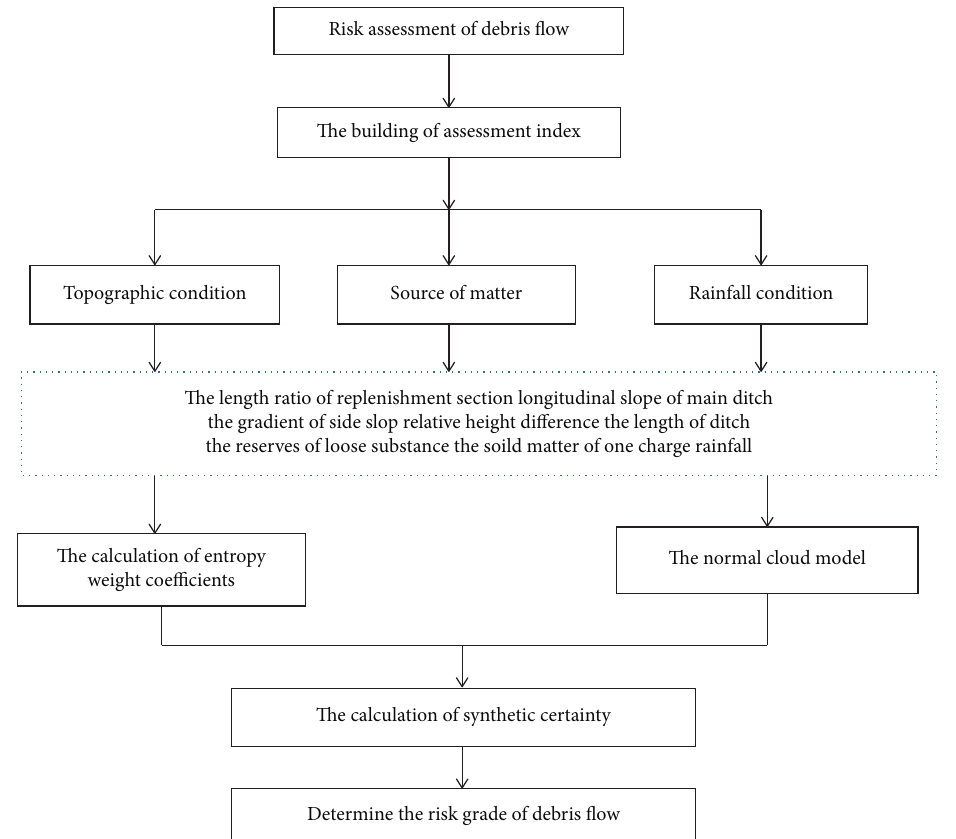
Figure 4: The risk assessment process of debris flow. Table 1: The standard classification of assessment index about debris flow. Risk